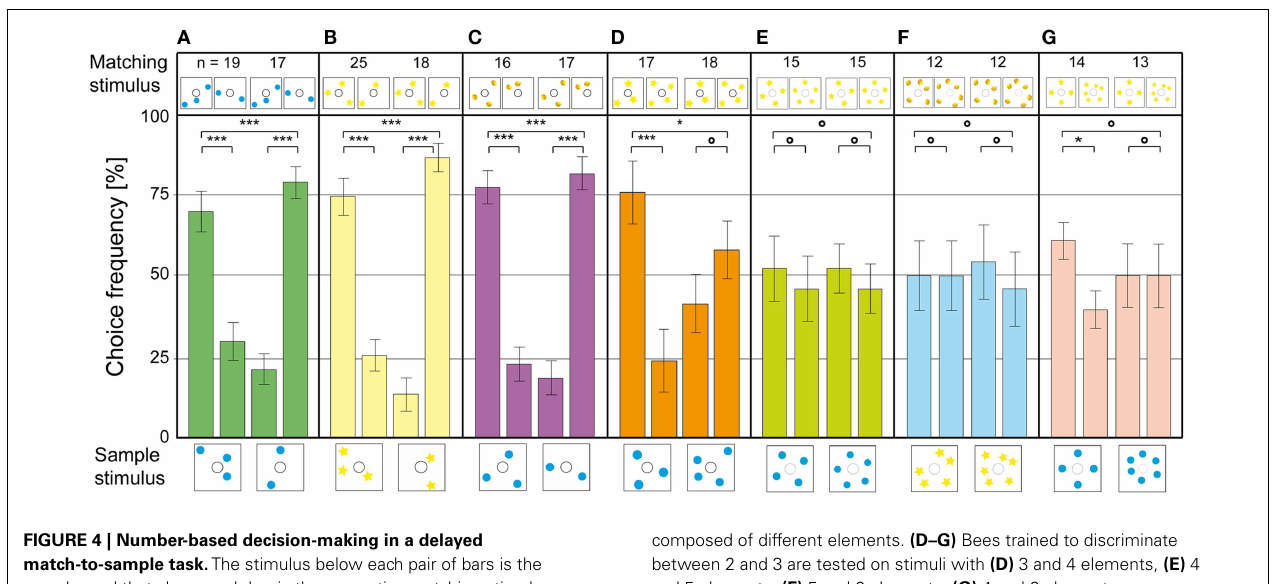
FIGURE 4 | Number-based decision-making in a delayed match-to-sample task. The stimulus below each pair of bars is the sample, and that above each bar is the respective matching stimulus. The data represent the pooled first choices of individual bees. (A) The configuration of dots on the sample and matching stimuli is randomized. (B) The blue dots are replaced by yellow stars, to test for abstraction to unknown stimuli. (C) Sample and matching stimuli are